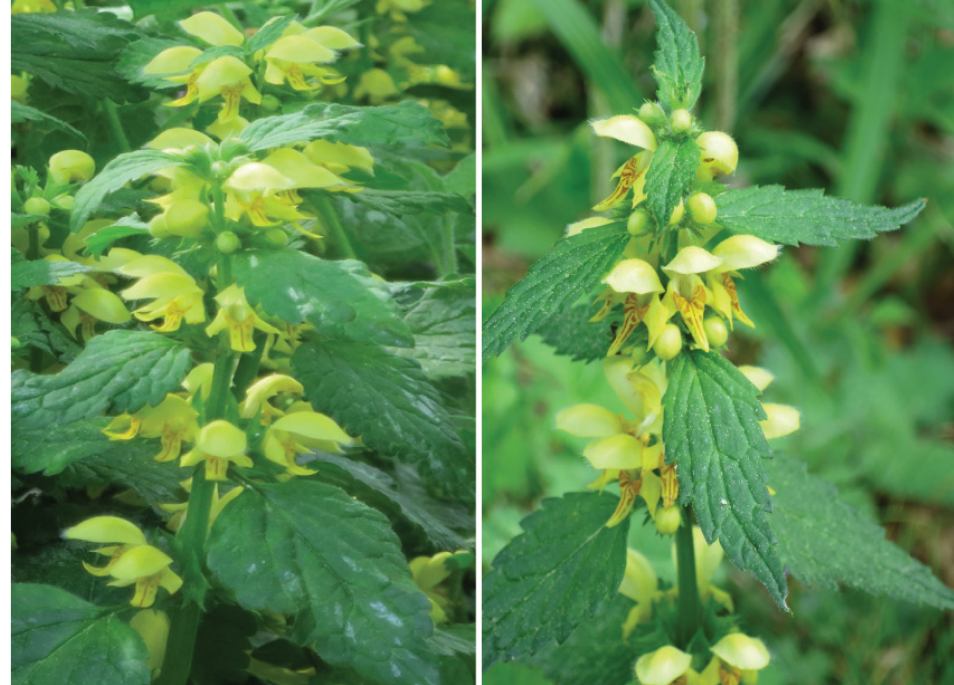
Figure 1. Inflorescences of the horticultural Lamium galeobdolon subsp. argentatum ( left ) and the native Lamium galeobdolon subsp. galeobdolon ( right ) in the same forest. Photos: H.-P. Rusterholz. It has been claimed that L. g. argentatum is a native cultivar, possibly descended from a variety of Lamium galeobdolon montanum (Pers.) Hayek with silver-spotted leaves and large yellow flowers [21,22]. Therefore, the horticultural breed L. g. argentatum has no natural distribution area [23]. Plants of this horticultural subspecies spread from gardens to natural habitats in many countries in Europe, North and South America, in Japan, Australia, and New Zealand [24]. Between 1990 and 2020, the number of L. g. argentatum records in the wild increased from about 2000 to over 27,000 in Europe [24]. Lamium g. argentatum is listed in the Global Register of Introduced and Invasive Species in Germany, Belgium,